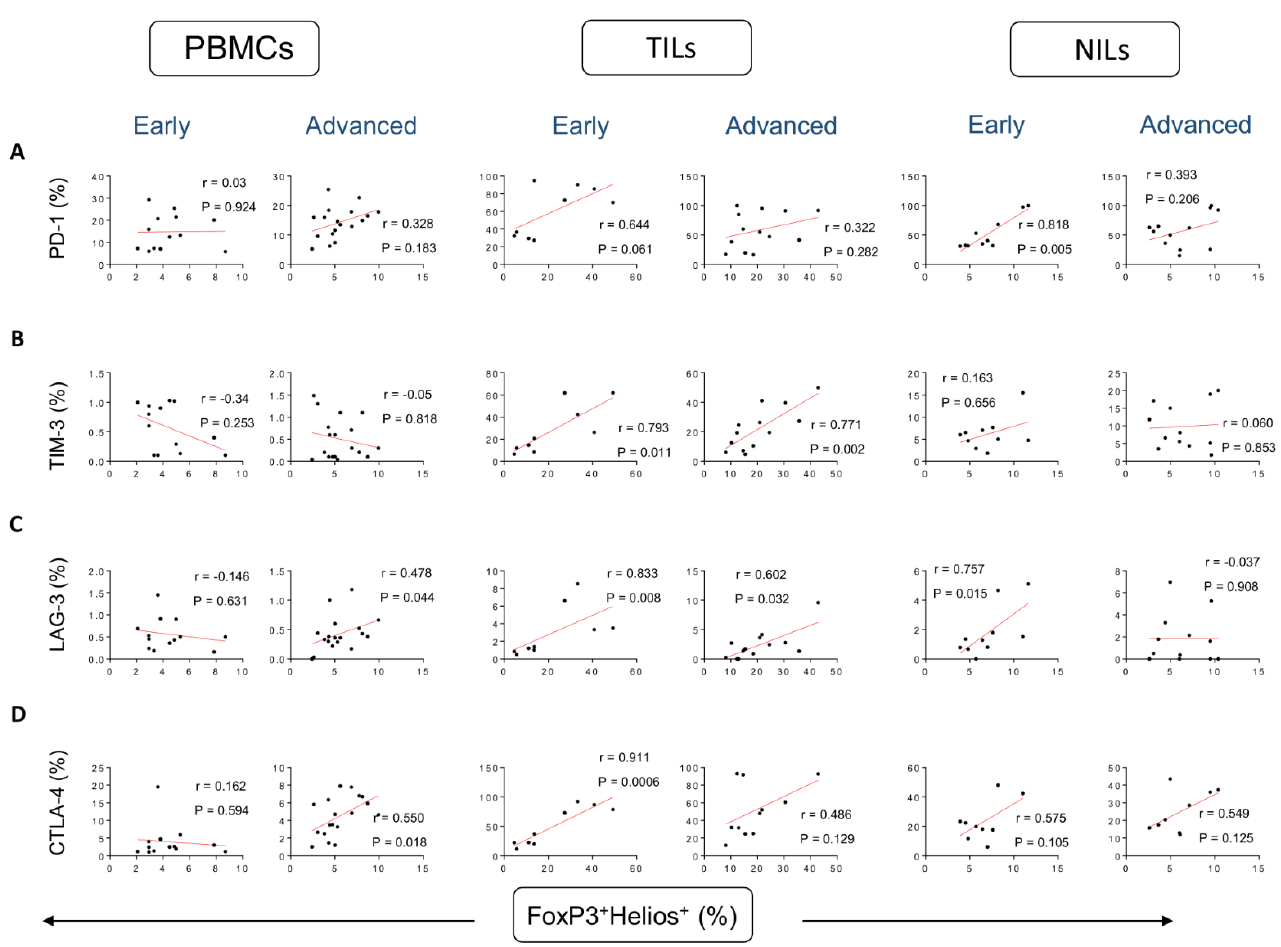
Figure 2. Correlations between frequencies of FoxP3 + Helios + and immune checkpoints in CD4 + T cells in CRC patients based on disease stages. Correlations between frequencies of CD4 + FoxP3 + Helios + Tregs with PD-1 + ( A ), TIM-3 + ( B ), LAG-3 + ( C ), and CTLA-4 + ( D ) in PBMCs, TILs, and NILs in CRC patients with early and advanced stages.